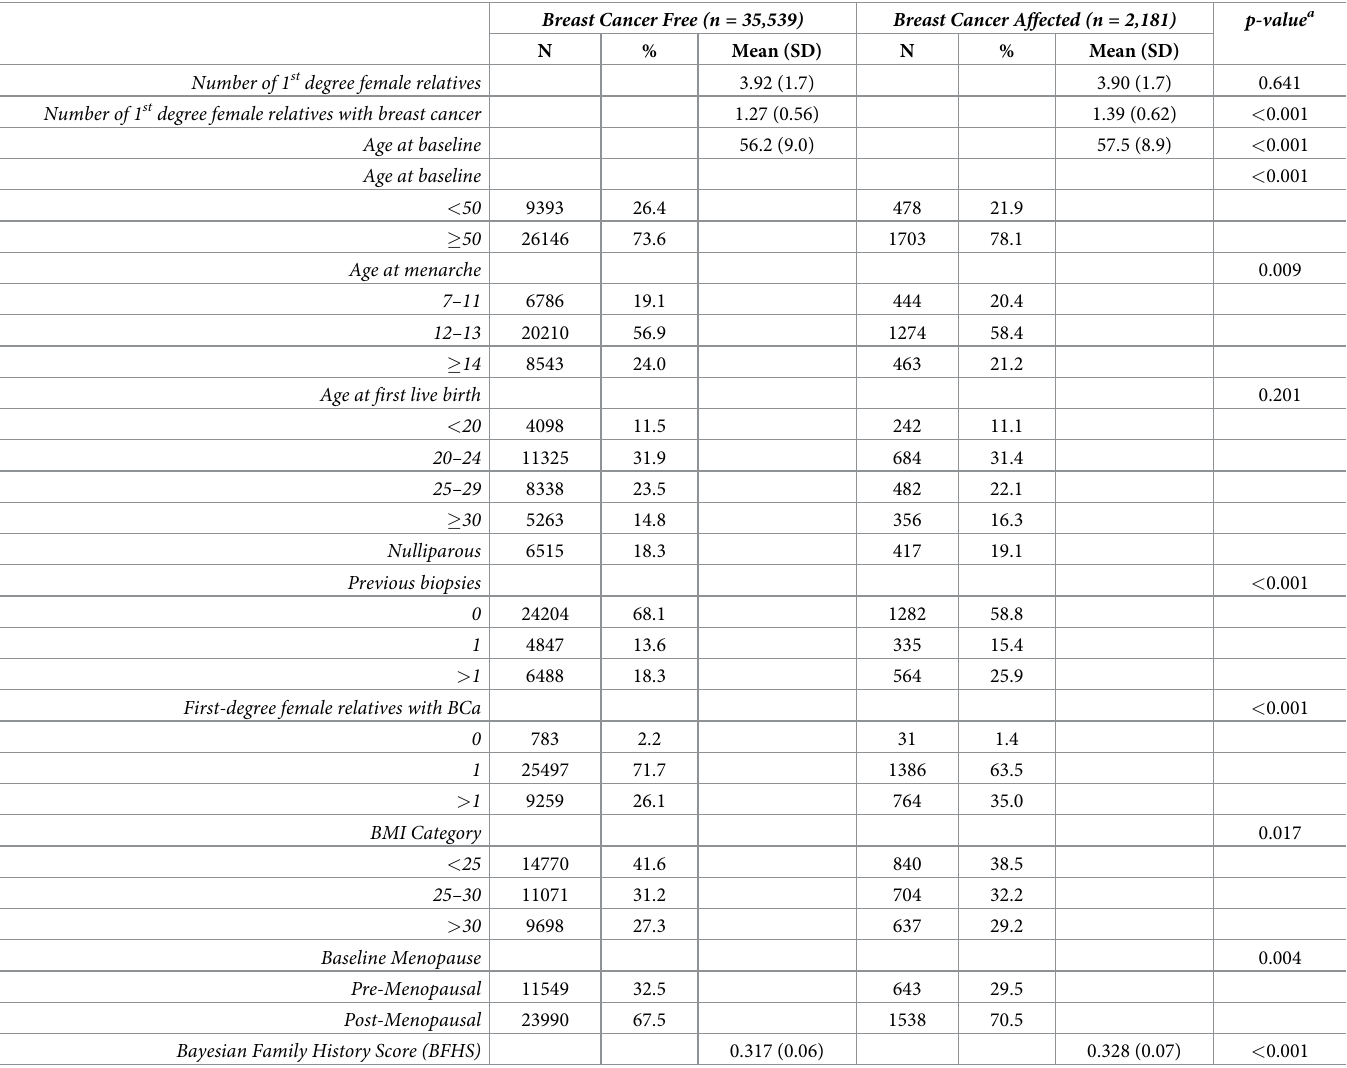
Table 2. Baseline characteristics for non-Hispanic white Sister Study